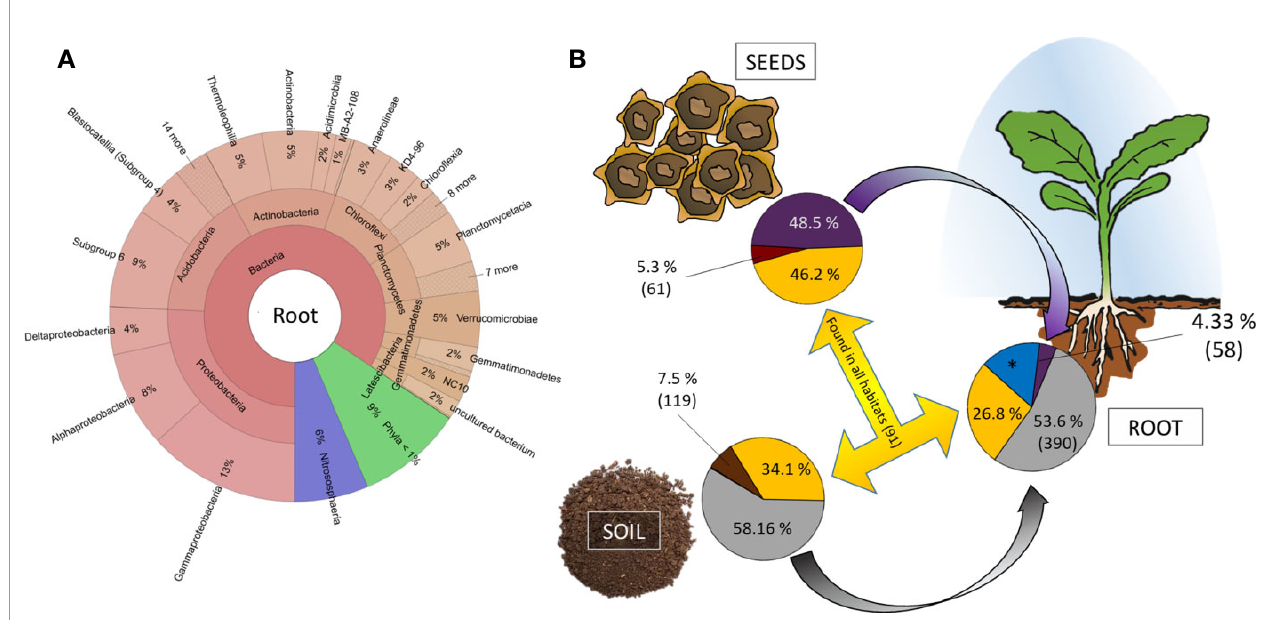
FIGURE 4 | Tracking the origin of bacterial genera found in the rhizosphere. (A) Krona chart of root communities on phylum level. Abundances are mean values across al cultivars. (B) Relative abundance and number of genera unique (soil: brown; red: seed; blue: root) and shared (yellow) between habitats. *: 417 genera accounting for 15.25% relative abundance exclusively found in rhizosphere and with thus unknown